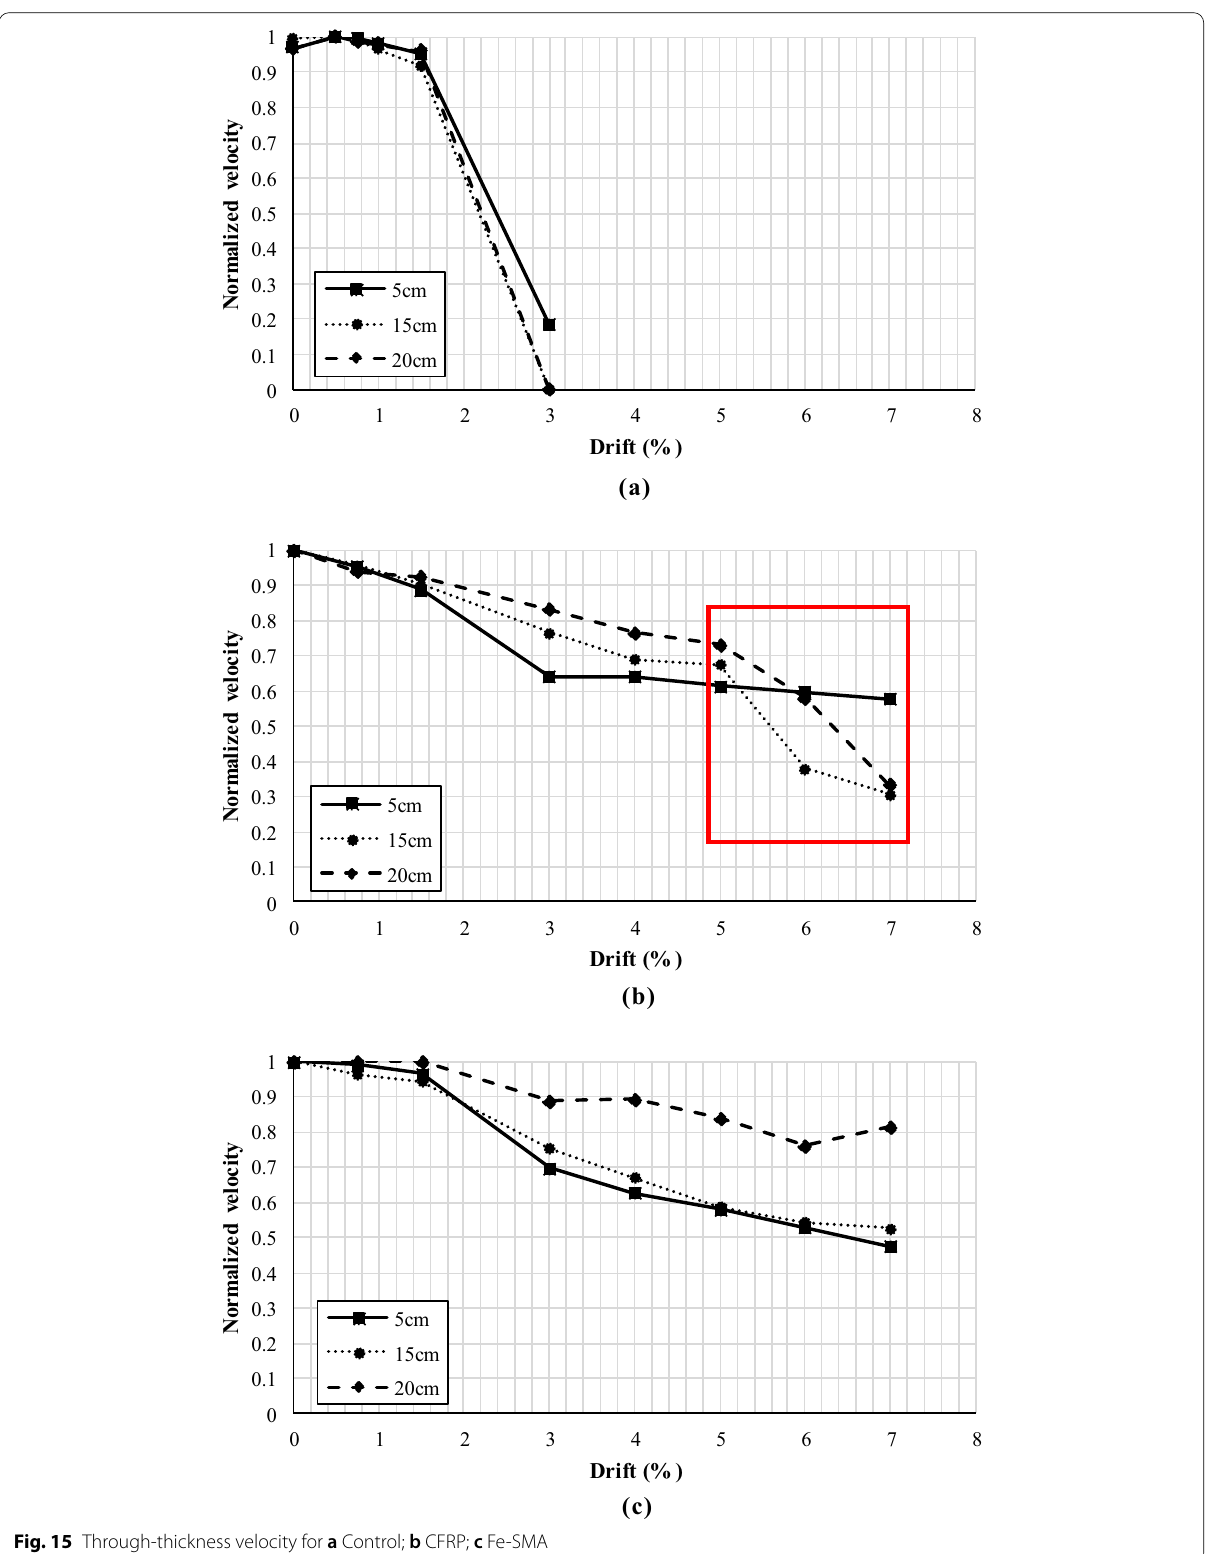
Fig. 15 Through-thickness velocity for a Control; b CFRP; c